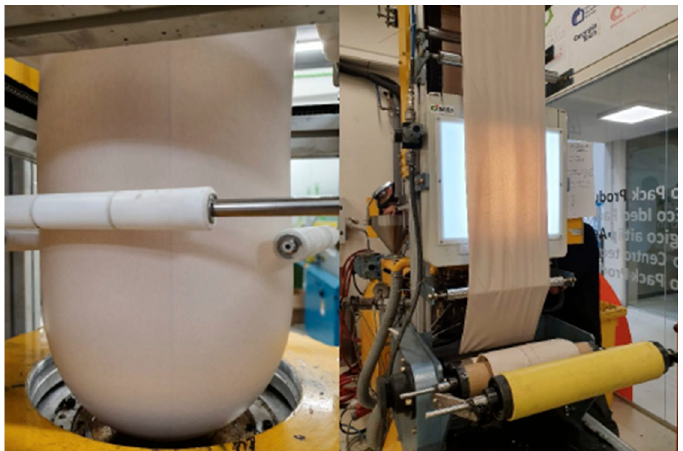
Figure 7. Blown film extrusion of micronized Mater-Bi EF04P with 2.5% TiO 2 and 5% 2nd genera- tion fiber.